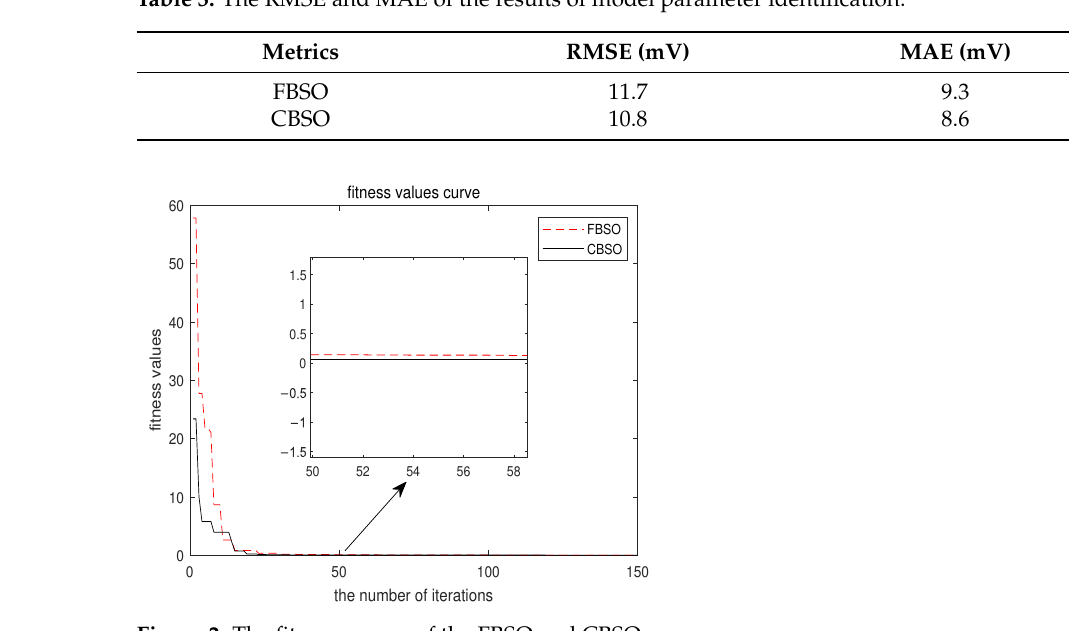
Figure 2. The fitness curves of the FBSO and CBSO.